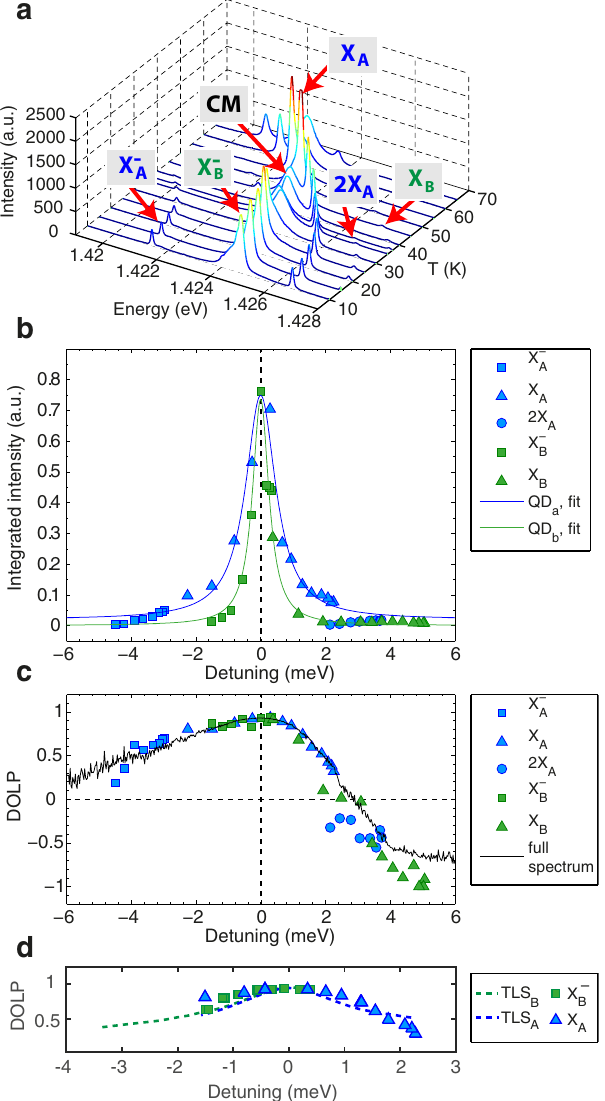
Figure 5. PL intensity and DOLP detuning dependence. ( a ) PL spectra (not normalized) of the 2QDs-cavity structure versus temperature. Integrated intensities ( b ) and degree of linear polarization (DOLP) ( c ) of the excitonic emission peaks versus detuning with respect to the cavity mode. In ( b ), the blue (green) solid lines represent Lorentzian fits to the data points of the X and X − features of QD A ( QD B ). In ( c ), the solid black line displays the DOLP of the full spectrum, acquired at 40 K high above saturation ( P = 5 mW ). ( d ) Comparison of the measured DOLP of the − X and X A transitions with simulated values. In ( b – d ), the detuning is defined as B